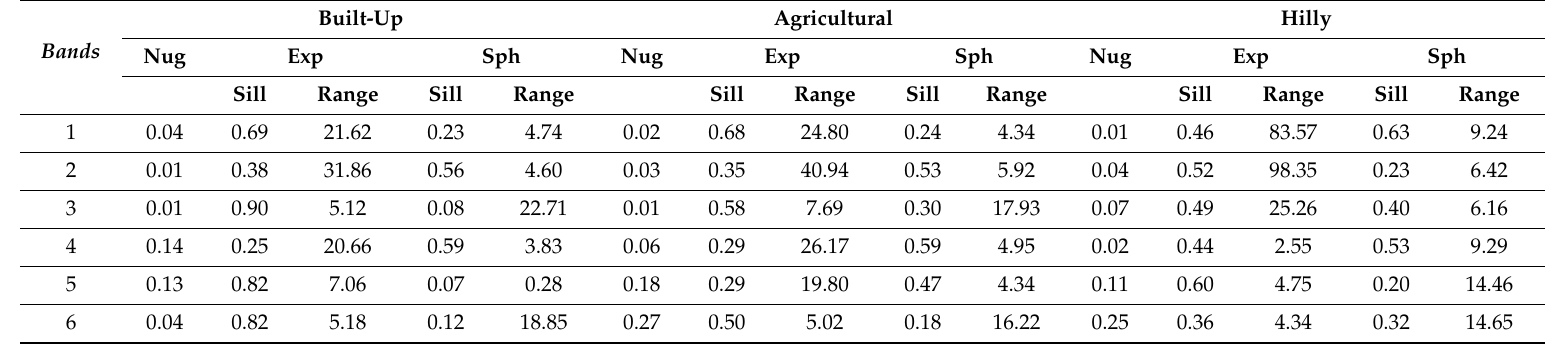
Table 3. Variogram model parameters (nug: nugget, exp: exponential, sph: spherical; units for ranges are number of pixels) for ICA-transformed image bands ∼ Z (cid:48) ( Z (cid:48) 6 1